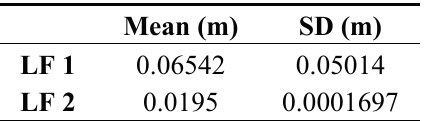
Figure 10. Target positioning errors based on the attitude estimates. Table 2. Statistical analysis of the positioning